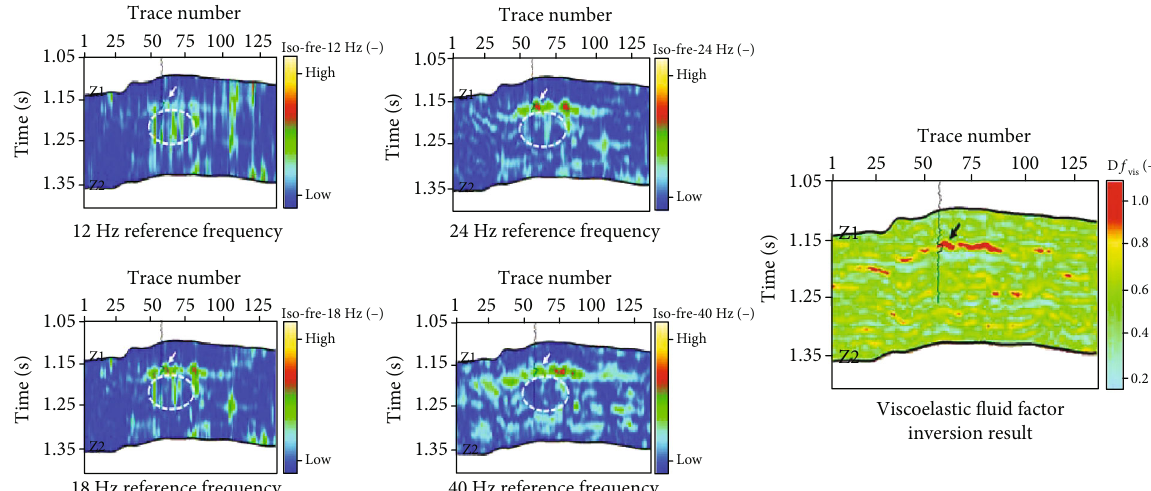
Figure 3: Viscoelastic fl uid factor inversion results compared with single frequency